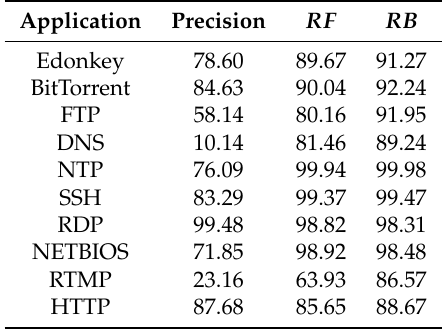
Table 9. M-MODC results for Precision, Recall in Flows ( RF ), and Recall in Bytes ( RB ).